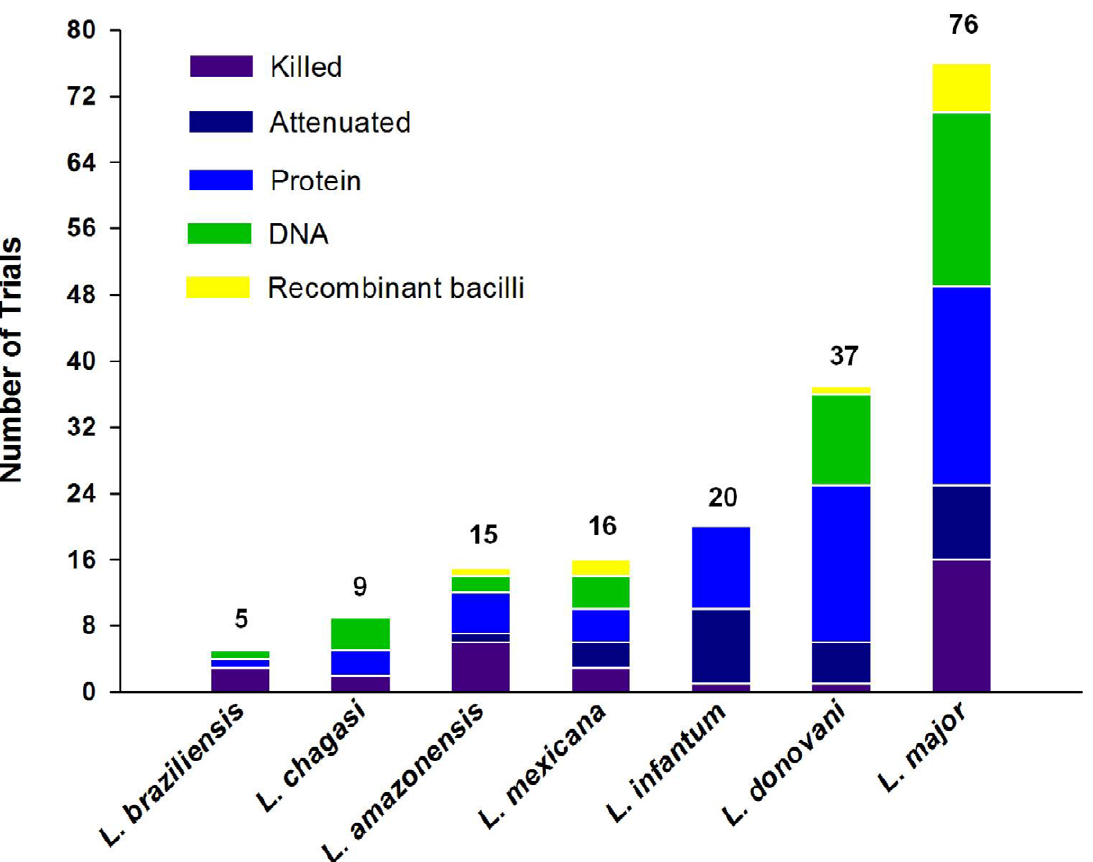
Figure 2. Profile of strategies used in leishmaniasis trials. Data are derived from Table S1, which contains a summary of all vaccines to date (both experimental and in clinical use). Bar graphs display the number of trials for each Leishmania species and the type of antigens that have been tested.